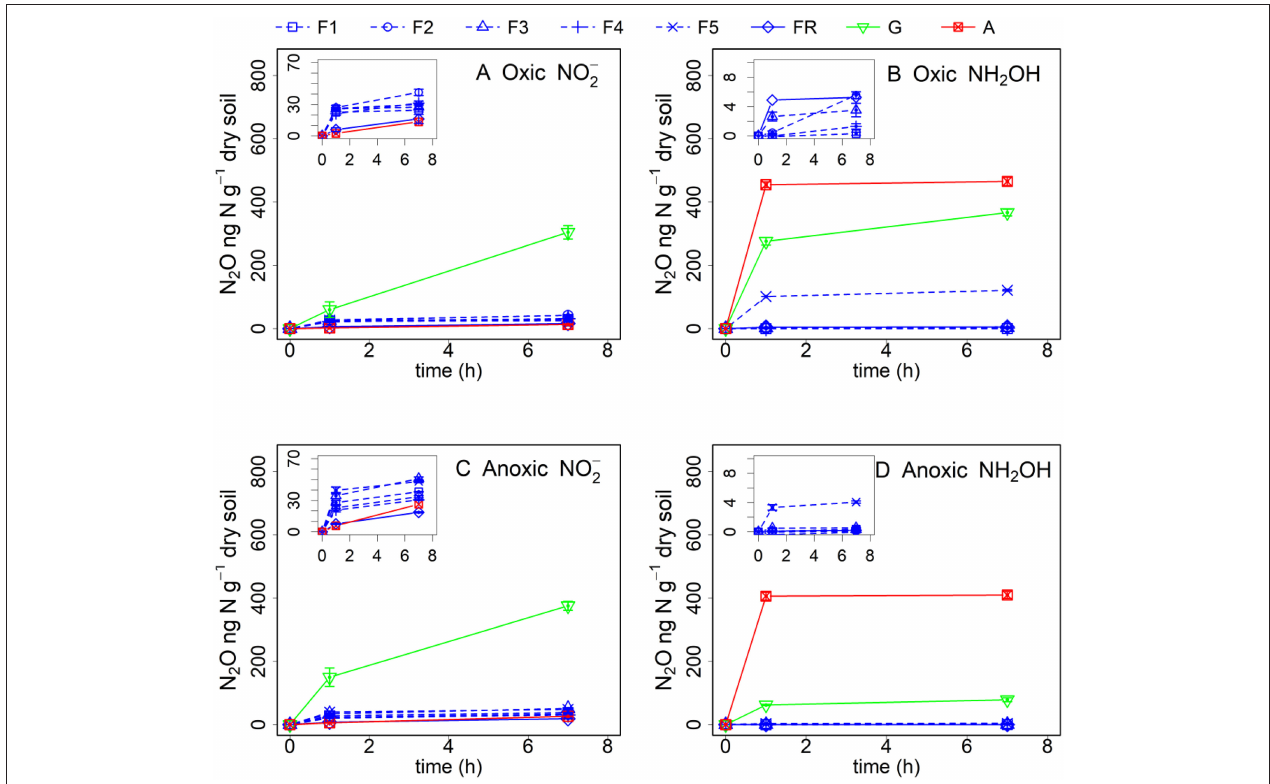
FIGURE 1 | Net N 2 O (ng N g − 1 dry soil) production in forest (F1, F2, F3, F4, F5, and FR), grassland (G) and arable land (A) soils without γ -irradiation after NO − 2 ( A : oxic, C : anoxic pre-incubation) and NH 2 OH (B : oxic, D : anoxic pre-incubation) addition. Net N 2 O production was calculated by subtracting mean N 2 O emission values after addition of pure water (as control) from the N 2 O emission values after addition of NO − 2 or NH 2 OH solution. The values are presented as mean ± standard deviation (SD, n =